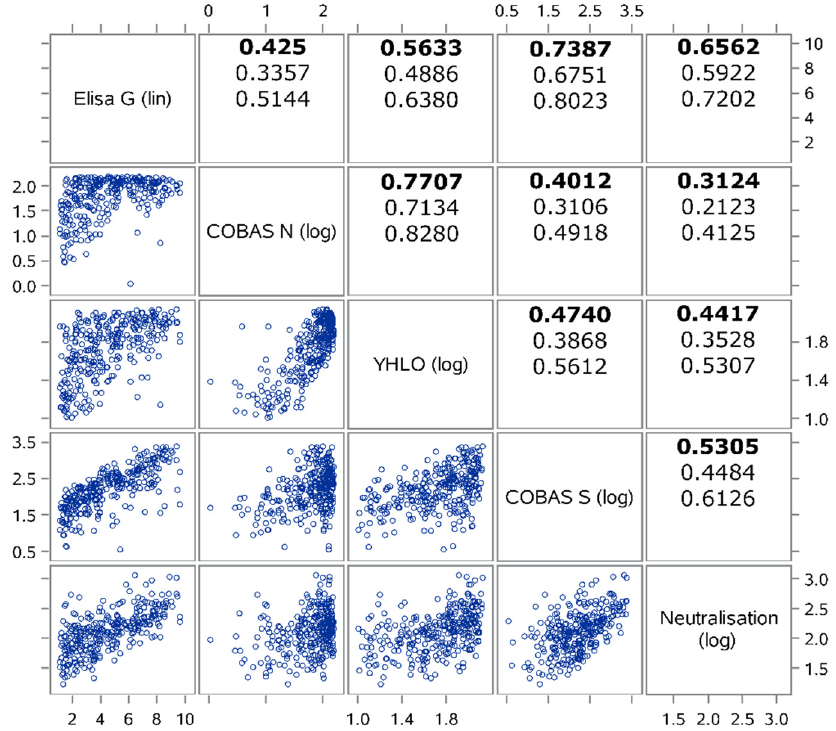
Figure 1. Scatterplot matrix of correlation between the different positive test results using logarithmic results for ECLIA based tests and neutralization. Also shown are Pearson correlation coefficients (bold type, 95%-CIs in the two rows below) to quantify the magnitude of linear association between antibody tests and neutralization within the subgroup ( n = 310) where all tests (ELISA_G, COBAS_N, COBA_S; YHLO; neutralization) were positive. (Further experimental inclusion constraints: COBAS_S ≤ 2500; ELISA_G ≤ 15; Neutralization IC 50 ≤ 2560).